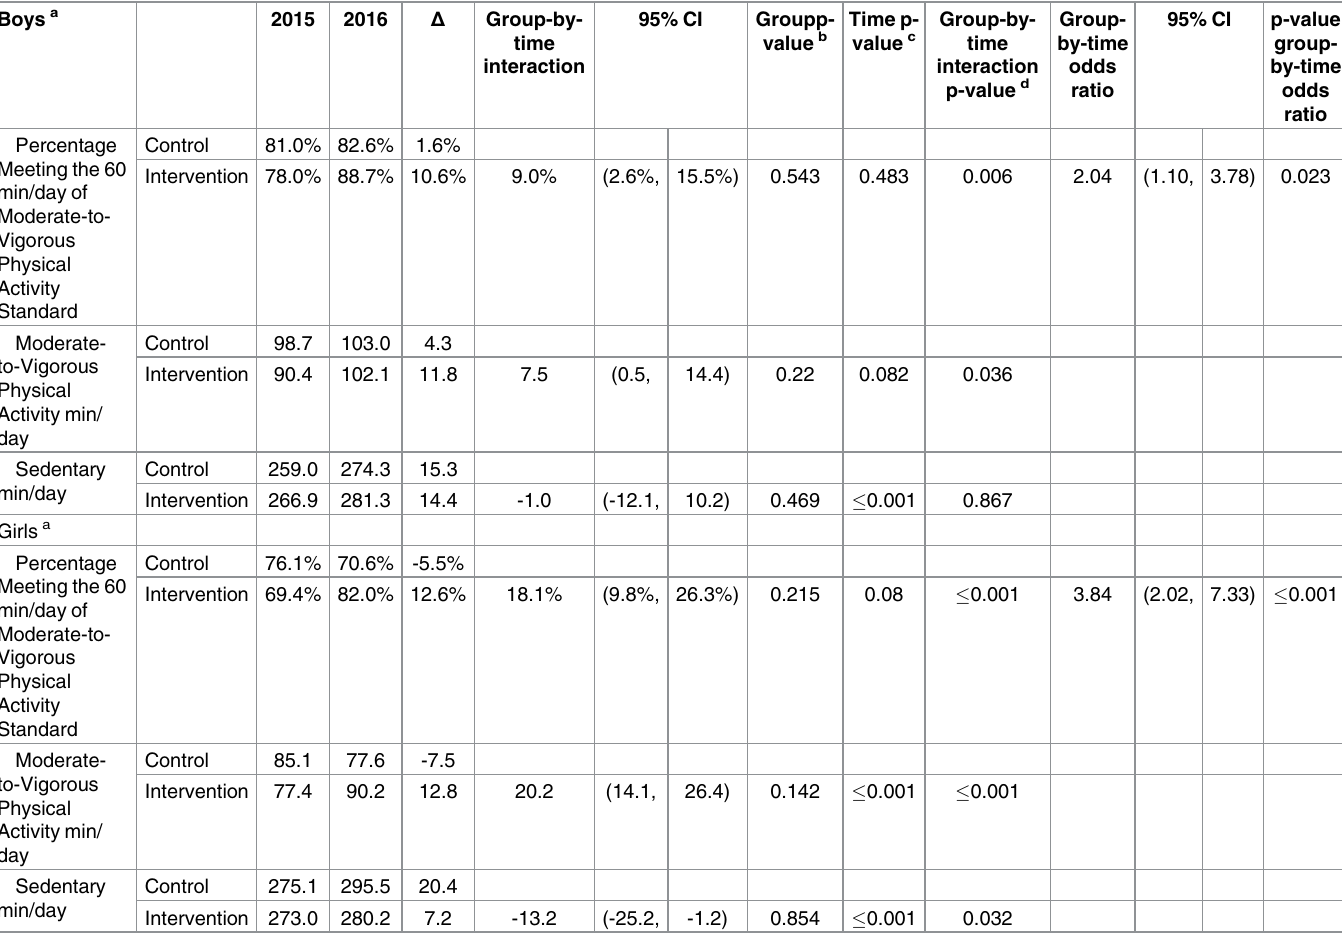
Table 2. Model implied and raw changes in physical activity levels of children during Summer Day Camp (SDC) program time. Boys